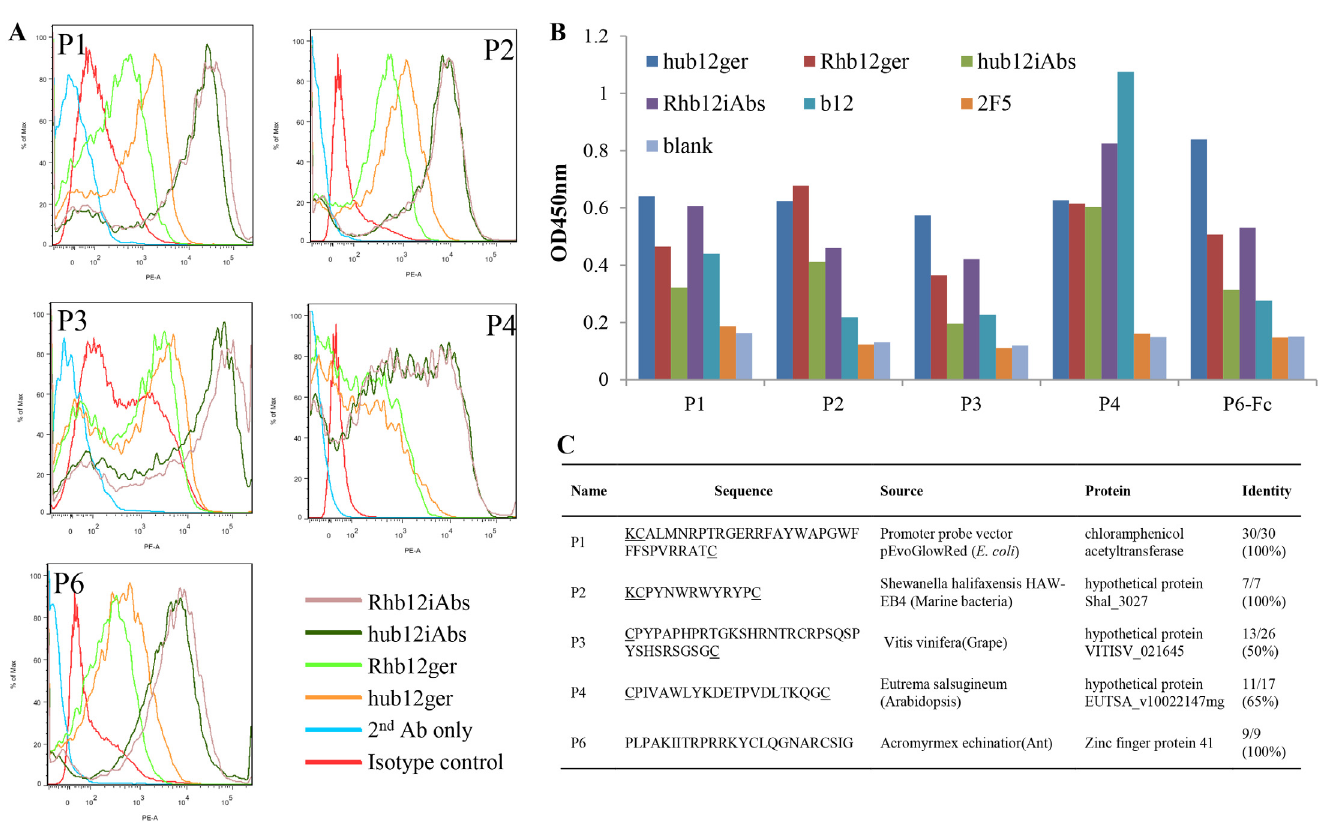
Fig 1. Identification of five (poly)peptides that bind to b12 germline and iAbs. A: Flow cytometry of yeast-displayed P1-4 and P6 stained with biotinylated human (hub12ger) and macaque (Rhb12ger) b12 germline scFvs, and human (hub12iAbs) and macaque (Rhb12iAbs) b12 iAbs. Isotype control: human mAb unrelated to Env gp120. B: Binding of human and macaque b12 germline scFvs, iAbs and mature IgG1 b12 at 50 μ g/ml to the isolated (poly) peptides by ELISA. IgG1s 2F5 and VRC01 were included as controls. The blank control contained no primary antibody. C: Sequences and origins of the isolated (poly)peptides. Underlined amino acids were added when constrained (poly)peptides were synthesized as conjugates to